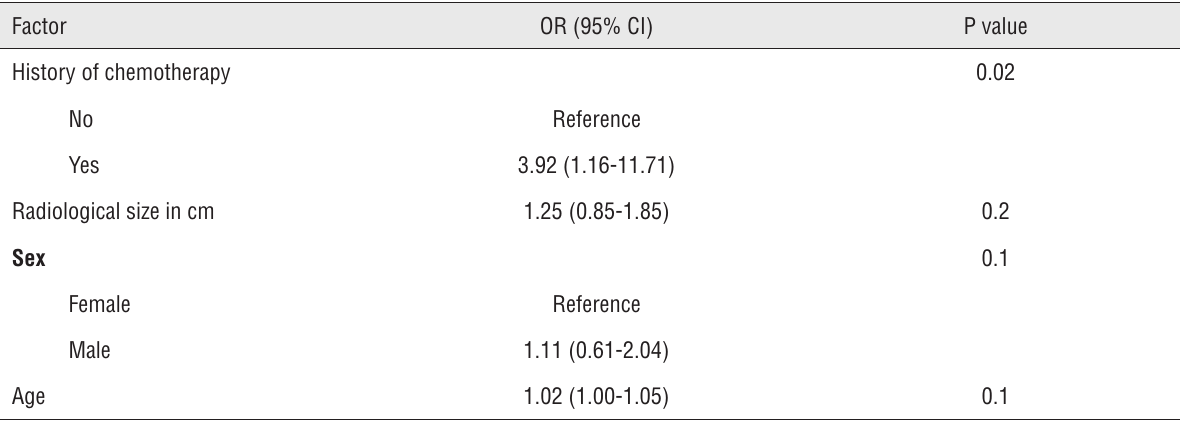
Table 3 - Multivariable analyses to evaluate the association of Fuhrman grade and a history of chemotherapy in localized RCC, adjusted for age, sex and radiological